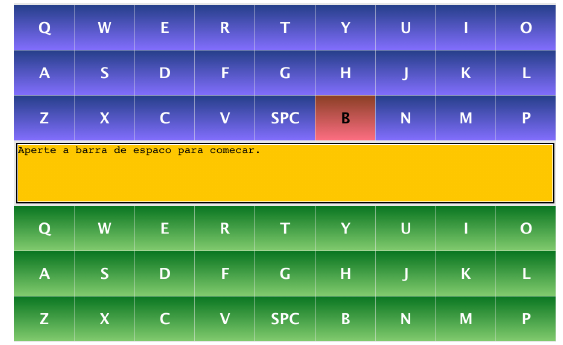
Fig. 3. Virtual keyboard using the context switching paradigm